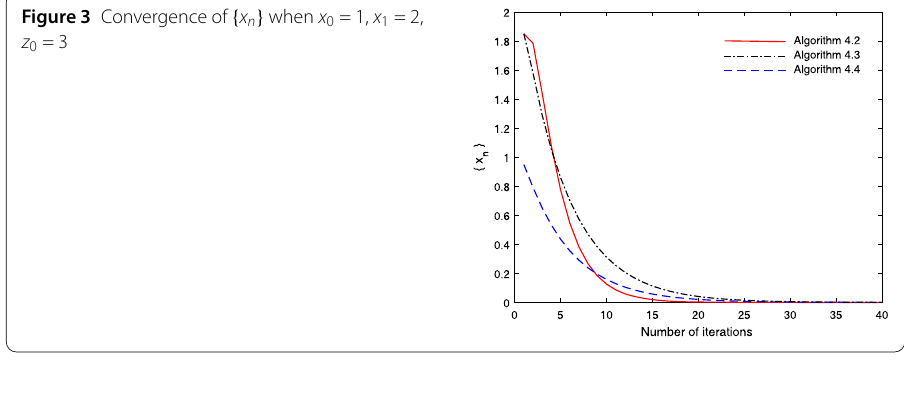
Figure 4 Convergence of { x n } when x 0 = –1, x 1 = –2,